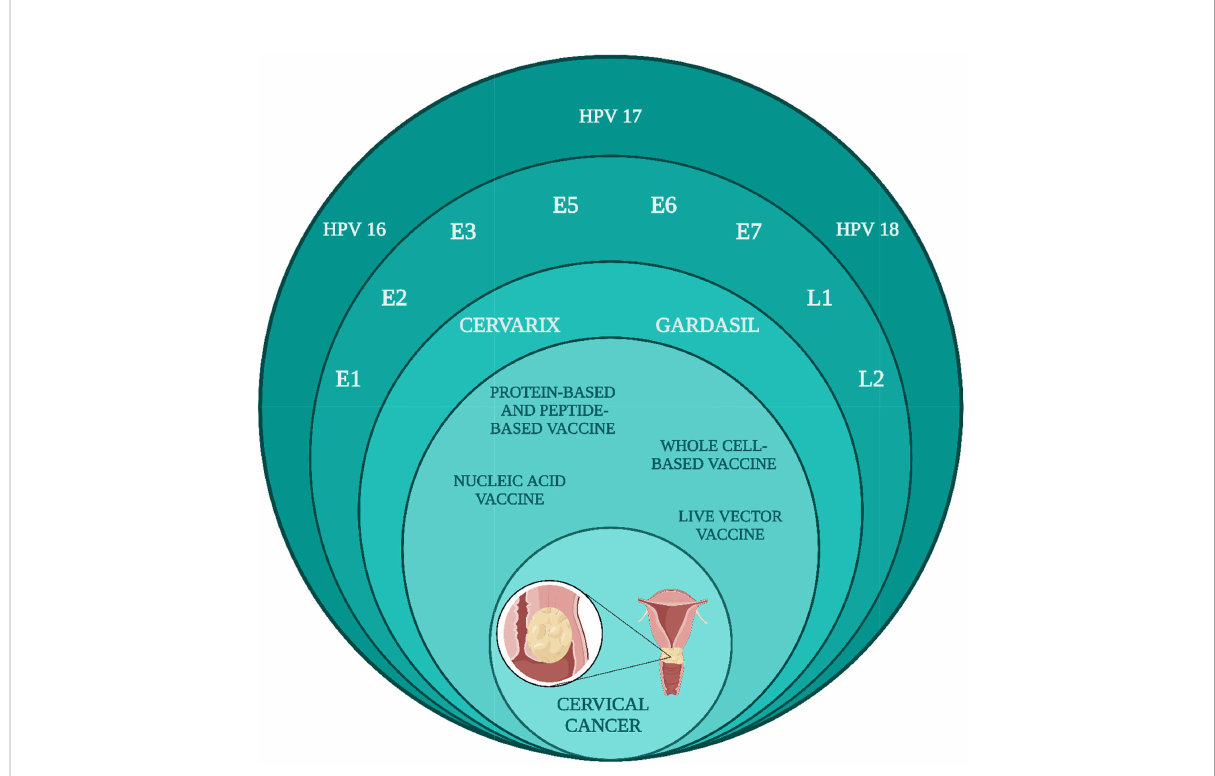
FIGURE 6 Projection of vaccines constituted from early and late proteins to cause regression against cervical cancer caused due to HPV16, 17, and 18